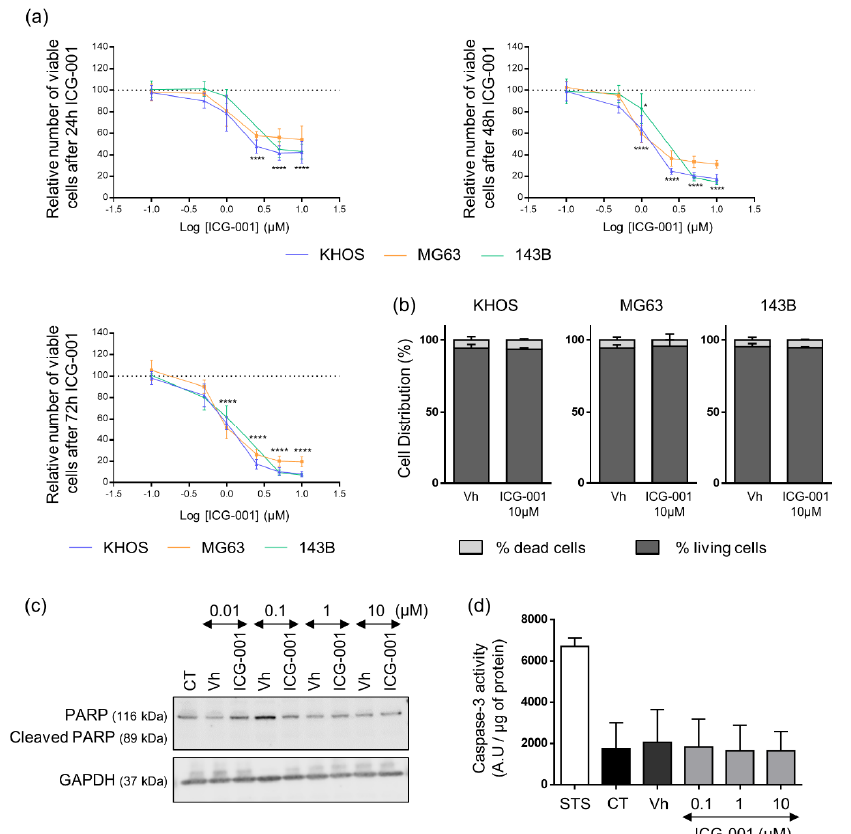
Figure 3. ICG-001 decreases KHOS, MG63 and 143B osteosarcoma cells viability. ( a ) Relative number of viable cells analyzed in cells treated with ICG-001 or vehicle (Vh) from 0.1 to 10 µM for 24, 48 or 72 h. At the end points, cells were stained with crystal violet and the curves represent the means ±SD relativized with the value of the vehicle (DMSO), of 5 independent experiments, each performed in triplicate. The dashed line represents the vehicle value set to 100. * p < 0.05; **** p < 0.0001 vs vehicle. ( b ) Cell death evaluated after 72 h of ICG-001 treatment (10 µM). Live and dead cells were counted in Malassez chamber after Trypan Blue staining. Histograms represent means ± SD of three independent experiments, each performed in duplicate. ( c ) Representative image of PARP analyzed by western blot in KHOS cells treated with ICG-001 or vehicle (Vh) from 0.01 to 10 µ M for 24 h. ( d ) Caspase-3 activity (expressed in Arbitrary Unit (A.U)/ µ g of protein) determined on KHOS cell lysates after 24 h of ICG-001 or vehicle (Vh) treatment by a fluorometric assay. Staurosporine (STS, 1 µ M) is used as positive control of caspase-3 activity. Histograms represent means ± SD of three independent